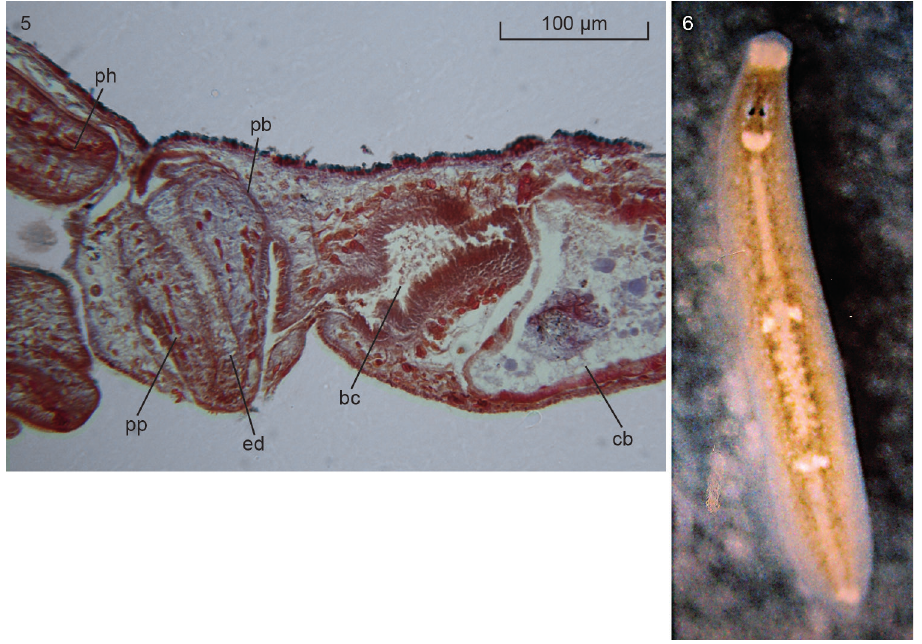
Figures 5–6. Paucumara trigonocephala . 5 ZMA V.Pl. 7279.1, microphotograph of sagittal section of the copulatory apparatus; anterior to the left 6 Dorsal view of live specimen from Lake Hi-numa, Japan. Scale bar not